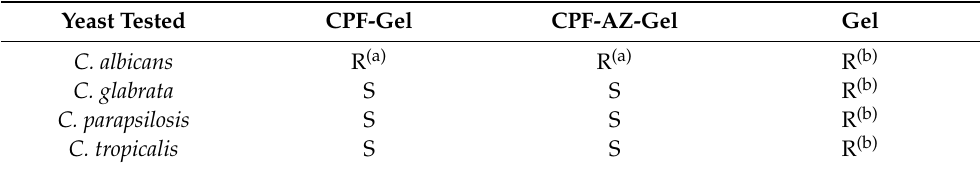
Figure 14. In vitro antifungal activity. ( A ) C. glabrata ( B ) C. parapsilosis ( C ) C. tropicalis and ( D ) C. albicans . The blue circles show the inhibition halo for CPF-gel and CPF-AZ-gel, the orange circles show the halo growth around the disc with an excipient (gel), and the yellow circles indicate the intrahalo growth of C. albicans. Table 6. Growth inhibition on Candida